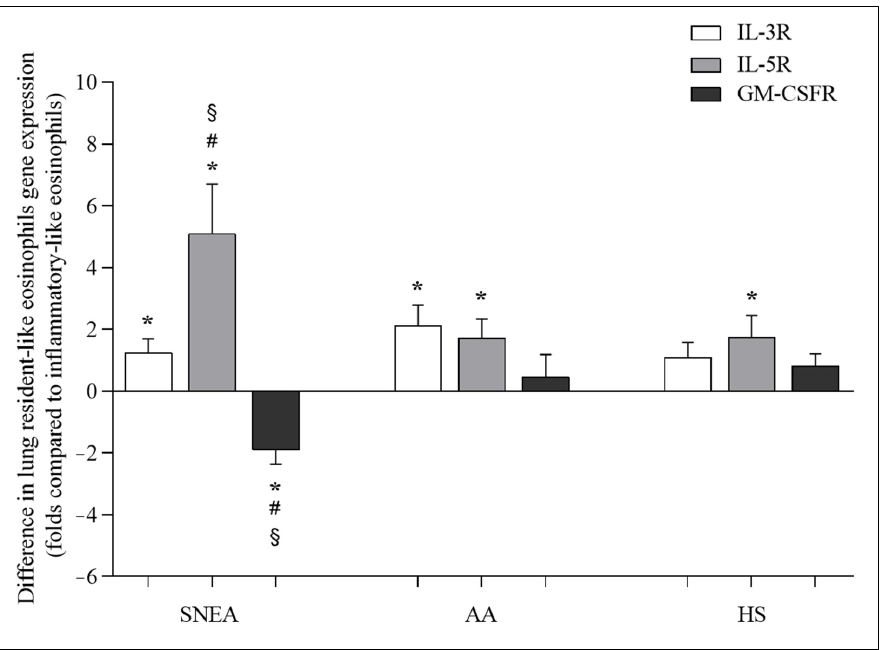
Figure 4. Differences in expression of IL-3R, IL-5R, and GM-CSFR genes between lung resident-like and inflammatory-like eosinophils in the same groups. IL-3R—interleukin 3 receptor; IL-5R—interleukin 5 receptor; GM-CSFR—granulocyte-macrophage colony-stimulating factor receptor. Severe nonallergic eosinophilic asthma (SNEA) group n = 10, nonsevere allergic asthma (AA) group n = 8, healthy subjects (HS) group n = 11. Data presented as the mean ± standard error of the mean, fold change over expression of IL-3R, IL-5R, and GM-CSFR gene on inflammatory-like eosinophils. * p < 0.05 compared with inflammatory-like eosinophils; # p < 0.05 compared with AA group; § p < 0.05 compared with HS group. Statistical analysis: between investigated groups, Mann–Whitney two-sided U-test; within one study group, Wilcoxon matched-pair signed-rank two-sided test. Data presented as the mean ± standard error of the mean.